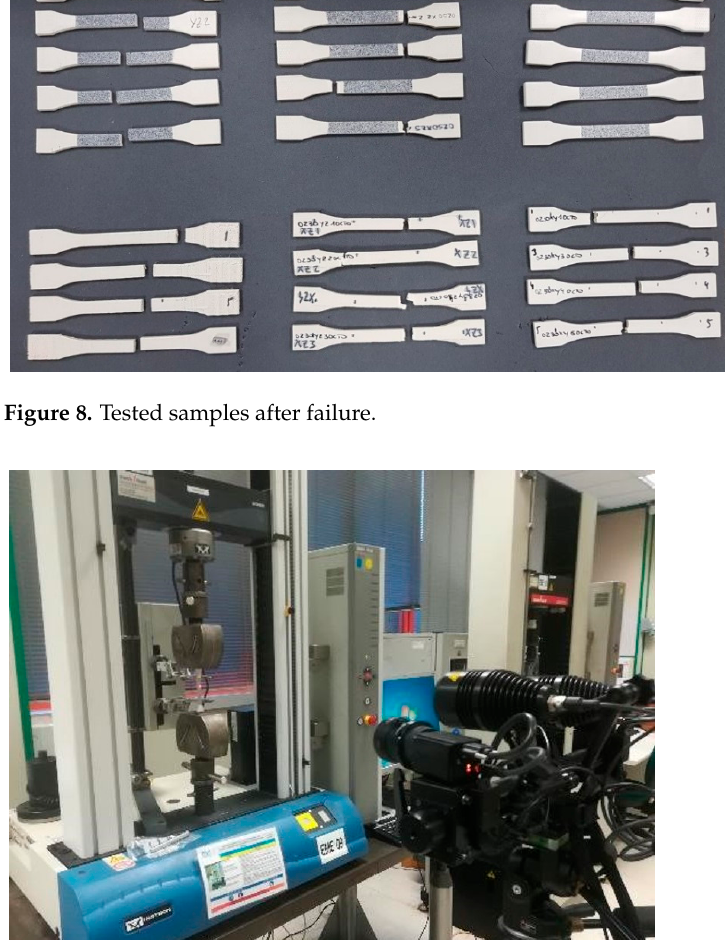
Figure 9. Digital image correlation (DIC) optical system.